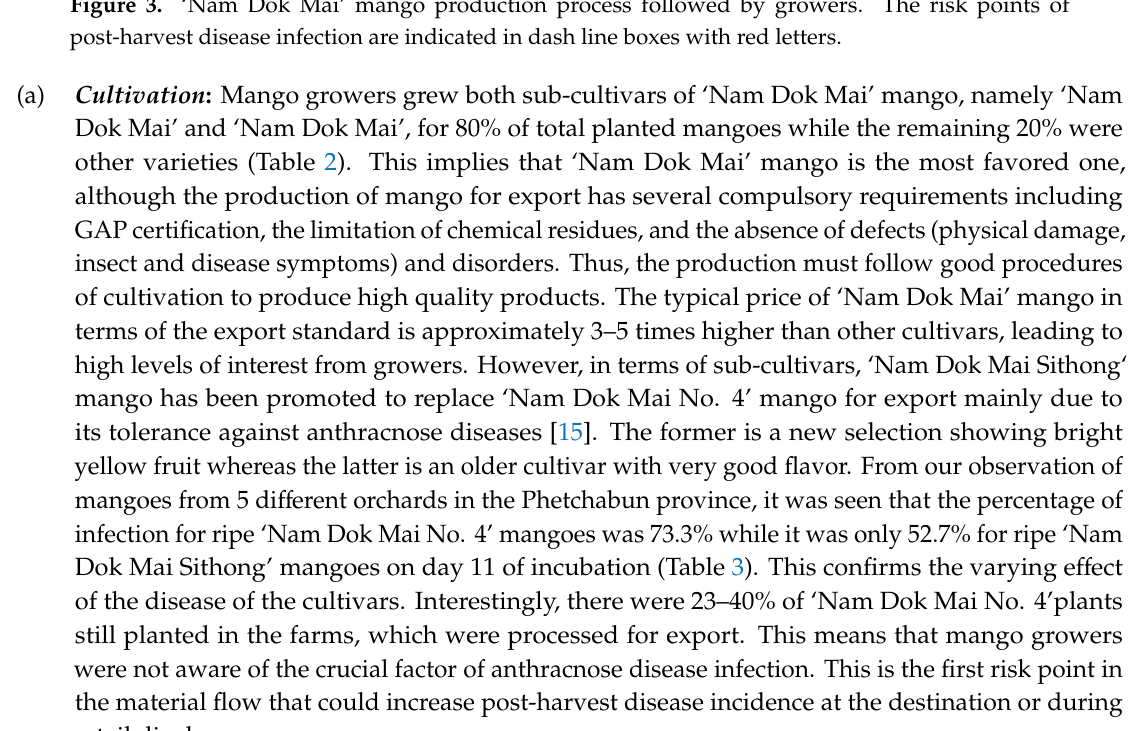
Table 2. Portions of mango cultivars grown in different farm sizes .